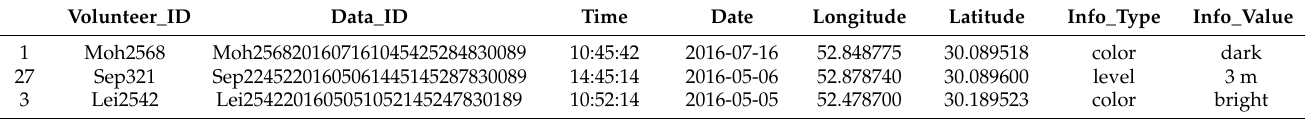
Table 2. Sample volunteered geographic information (VGI) data collected in [79]